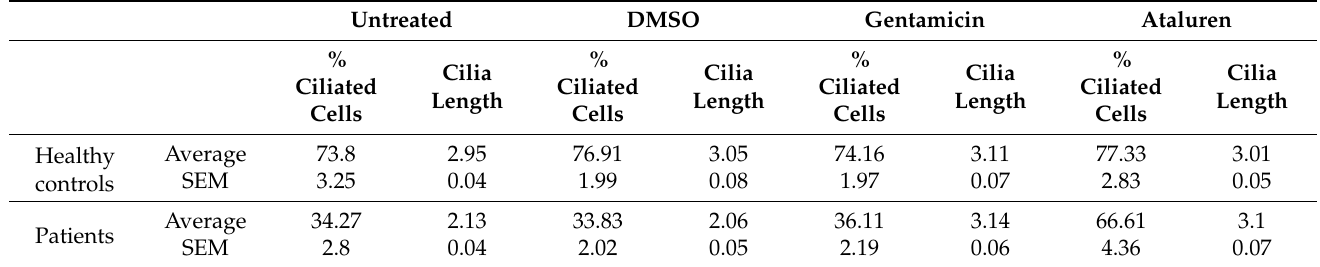
Figure 3. Ciliogenesis and cilia length analyses. ( A ) A boxplot displaying percentage of ciliated cells among untreated fibroblasts from five healthy controls and six FAM161A patients (untreated or after different treatments), obtained in three independent experiments (a total of 300 cells per each healthy control or patient were counted). For quantification of the percentage of ciliated cells, the number of DAPI stained nuclei was correlated to the number of ciliated cells (Figure 3A; y -axis). ( B ). Boxplot of cilia length on untreated fibroblasts from five healthy controls ( n = 1107 cells) and six FAM161A patients (untreated or after different treatments) ( n = 3075), obtained in three independent experiments. The ciliary length was determined based on the acetylated tubulin staining (Figure 3B; y -axis). The significance levels were set when p < 0.05 (*), p < 0.01 (**), p < 0.001 (***). Table 2. Summary of ciliogenesis and cilia length analyses. Summary of the average percentage (%) of ciliated cells and cilia length in fibroblasts from healthy controls and patients without any treatment and following different